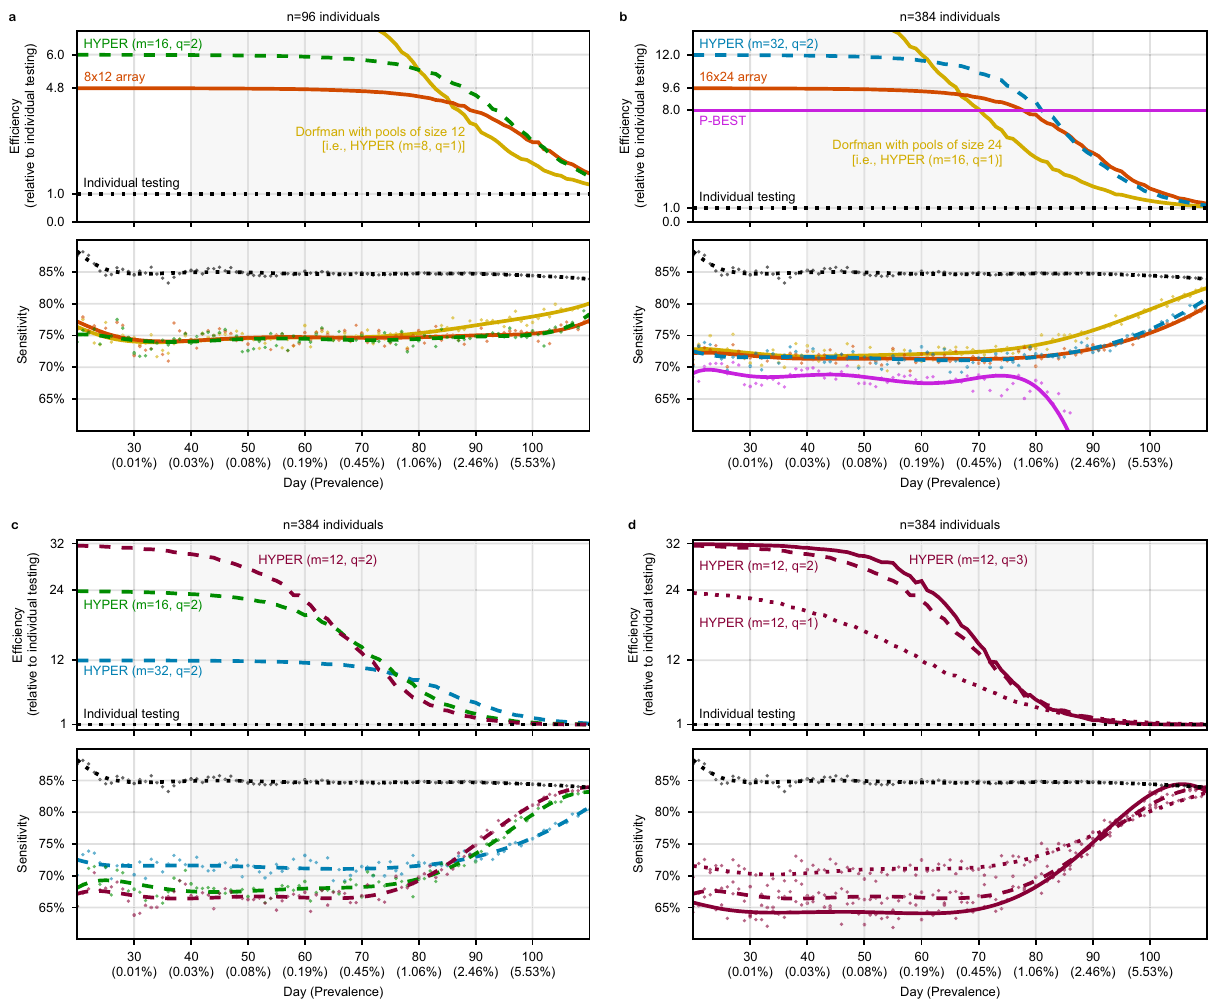
Fig. 2 Ef fi ciency and sensitivity of pooled testing during a simulated epidemic. Average values of ef fi ciency (relative to individual testing) and sensitivity of a variety of pooling designs are shown for each day, with results averaged across 200,000 random trials. For sensitivity, raw averages are shown as dots with degree-8 polynomial fi ts overlaid as curves; the curves for ef fi ciency depict raw averages. During the days 40 – 90 (highlighted), the prevalence grows exponentially from 0.03% to 2.46%. a , b Comparison of HYPER with alternative methods that use n = 96 individuals per batch ( a ) or n = 384 individuals per batch ( b ). HYPER designs with q = 2 splits were chosen to have the same maximum pool sizes ( nq / m = 12 for H 96,16,2 ; nq / m = 24 for H 384,32,2 ) as the array designs. Dorfman designs (i.e., HYPER designs with q = 1) with matching pool sizes are also included. Sensitivity (bottom panels) depends heavily on pool sizes, due to dilution of viral loads. c , d HYPER evaluated with varying numbers of pools ( c , m = 32, 16, 12) and numbers of splits ( d , q = 1, 2, 3). The designs are affected by the increasing prevalence over time to varying degrees. As prevalence increases, ef fi ciency decreases (as more stage 2 tests become necessary), while sensitivity increases (as larger viral loads begin to rescue small viral loads that would have been missed). More ef fi cient designs tend to be less sensitive, creating a